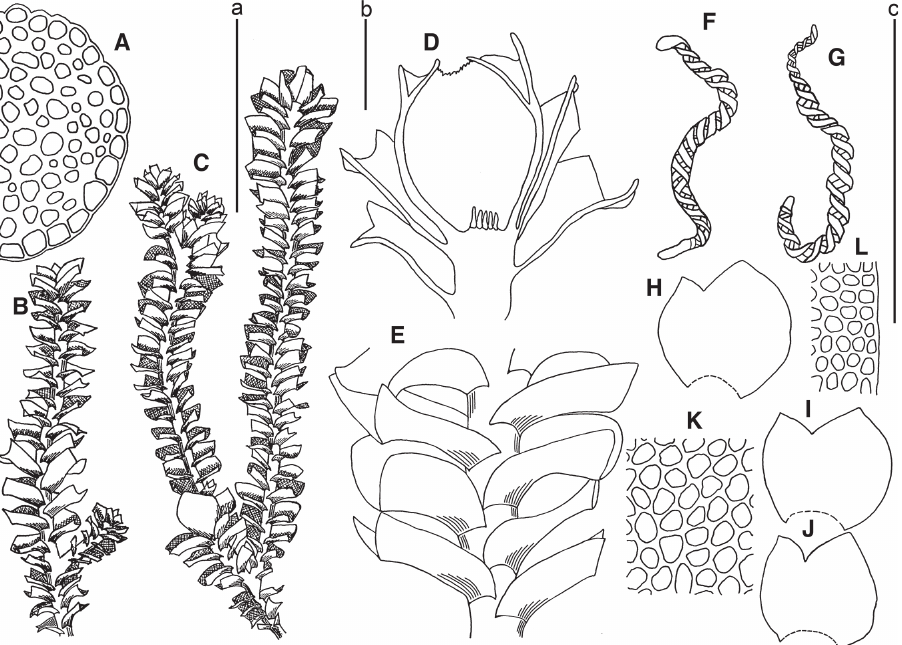
Figure 3. Marsupella koreana Bakalin et Fedosov A stem crops section (fragment) B male plant habit C female plant habit D gynoecium longitudinal section E shoot (fragment) F, G elaters H–J leaves K midleaf cells L cells along leaf margin. Scale bars: a 100 μm ( A, F, G, K, L ); b 1 mm ( B, C ); c 1 mm ( D, E, H–J ). All from Choi 3511